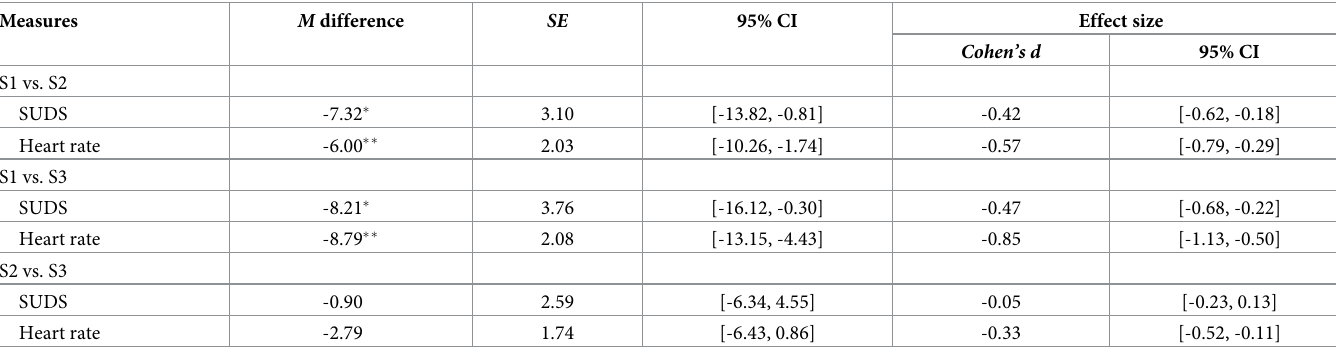
Table 4. Pairwise comparisons of mean Subjective Units of Discomfort Scale and heart rate measures (N = 19). Measures M